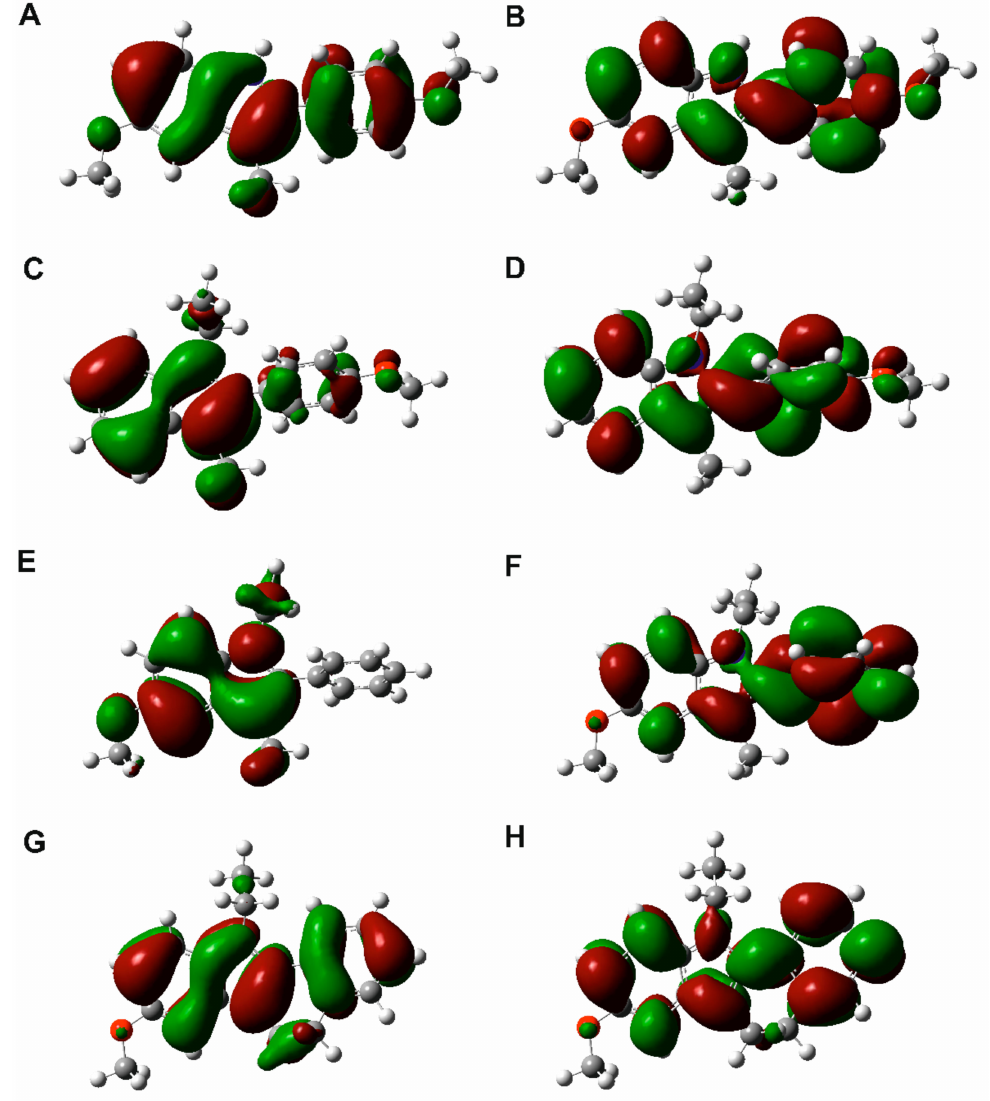
Figure 10. The shapes of HOMO ( A , C , E , G ) and LUMO ( B , D , F , H ) orbitals for compounds 1 ( A , B ), 2 ( C , D ), 3 ( E , F ) and 4 ( G , H